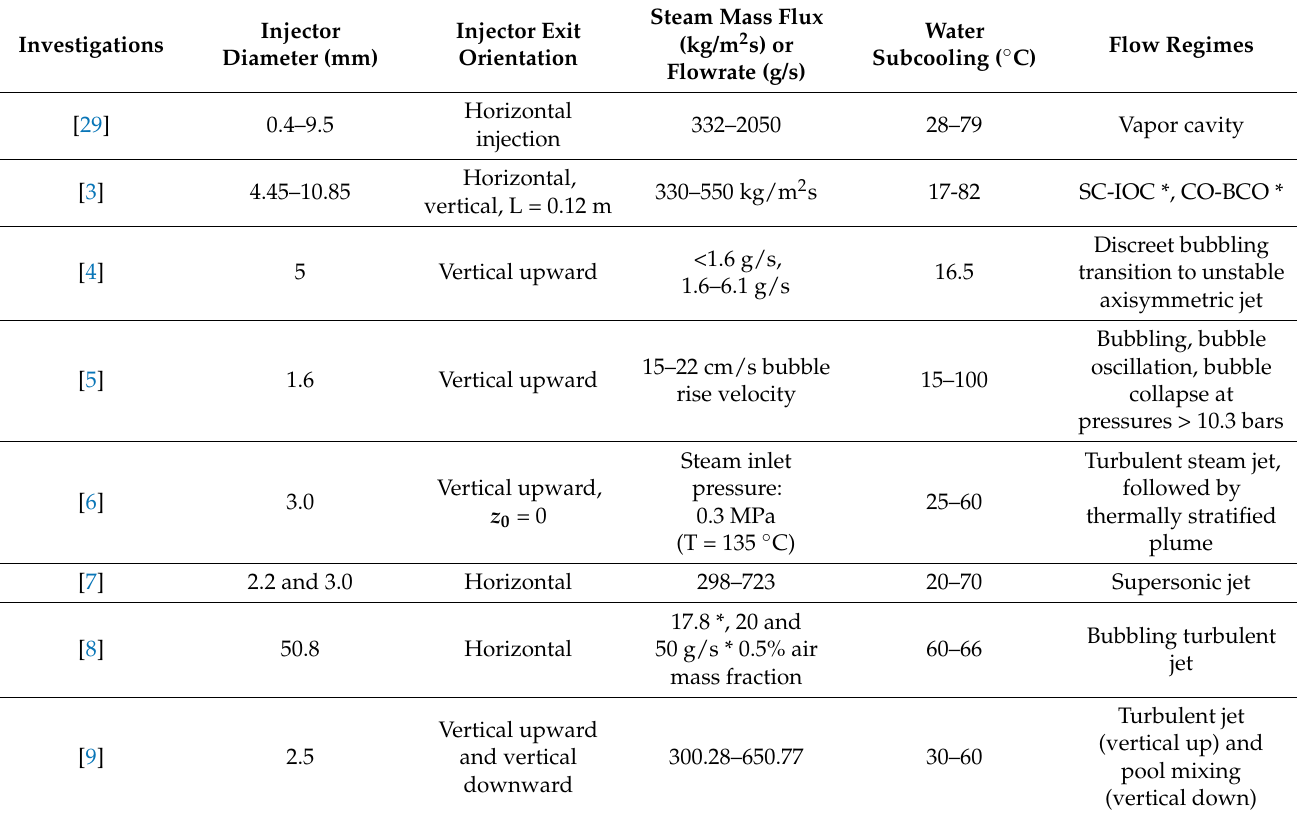
Table 1. Condensation regimes and experimental parameters for steam injected into subcooled